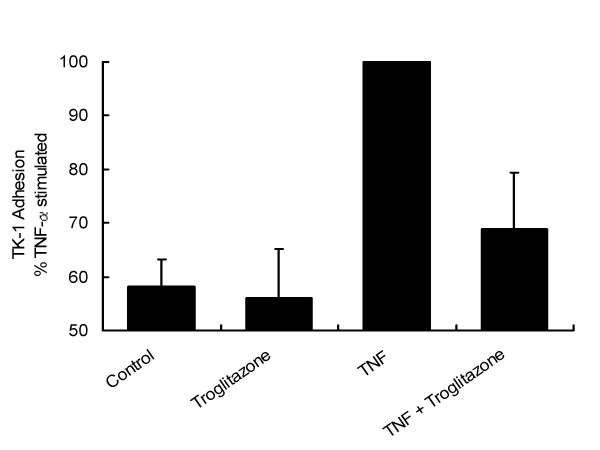
Adhesion of α4β7 expressing lymphocytes (TK-1) to TNF-α stimulated endothelium. TNF-α stimulation (24 h) significantly increased adhesion of TK-1 lymphocytes to monolayers of SVEC cells. Troglitazone (20 μM) significantly reduced TK-1 adhesion in response to TNF-α stimulation at 24 h (Fig. 6).